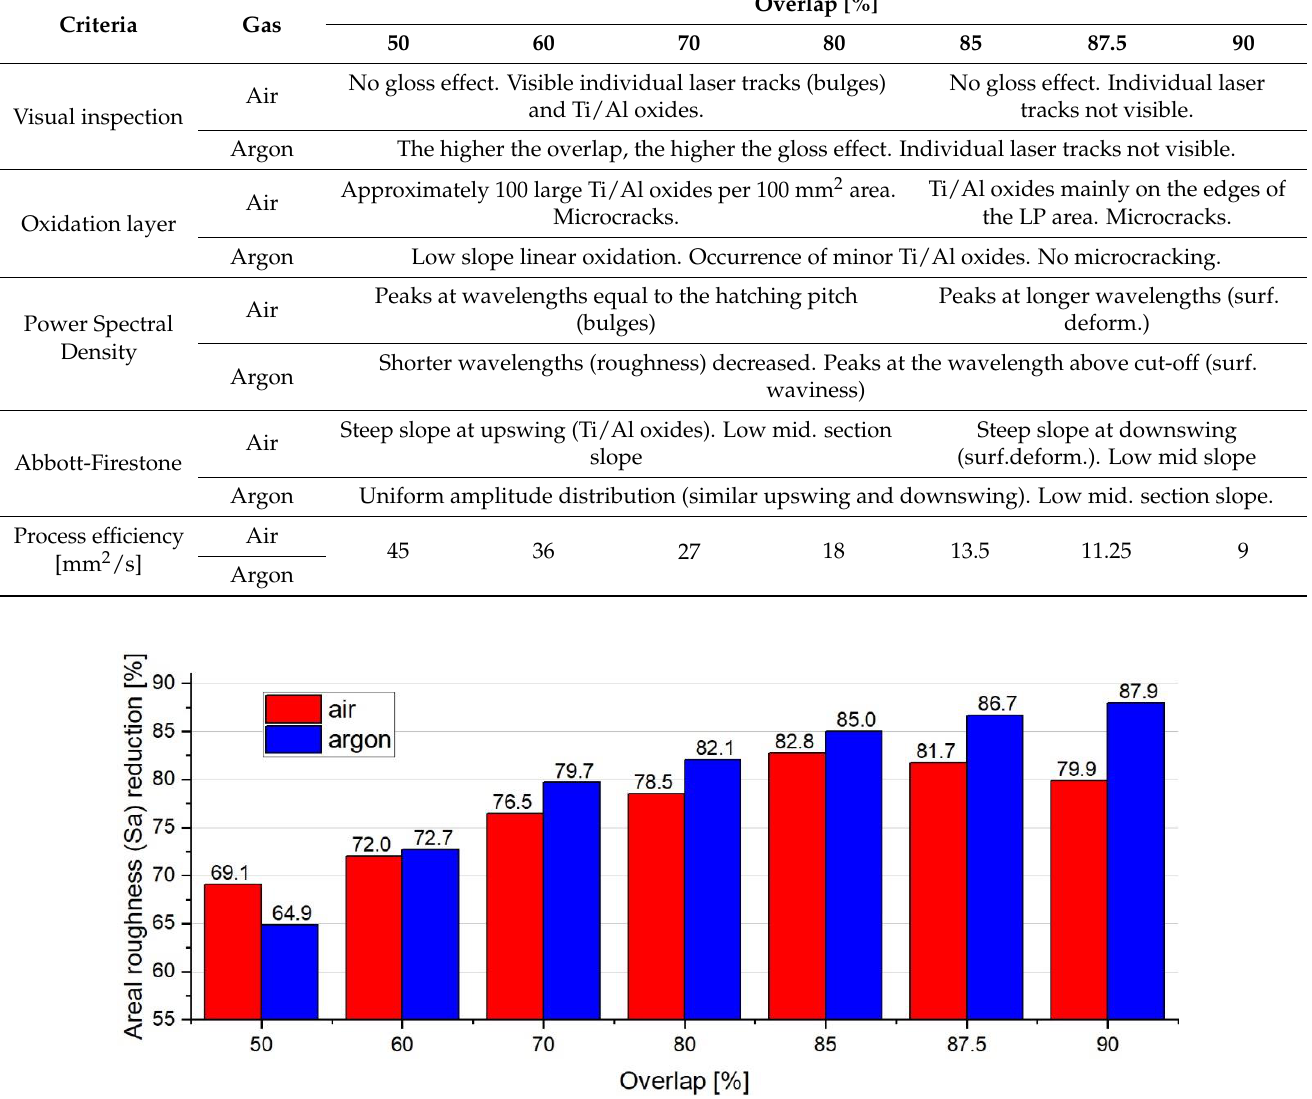
Figure 13. Comparison of the average areal roughness (Sa) reduction after applying LP under the effect of the air and argon atmospheres.